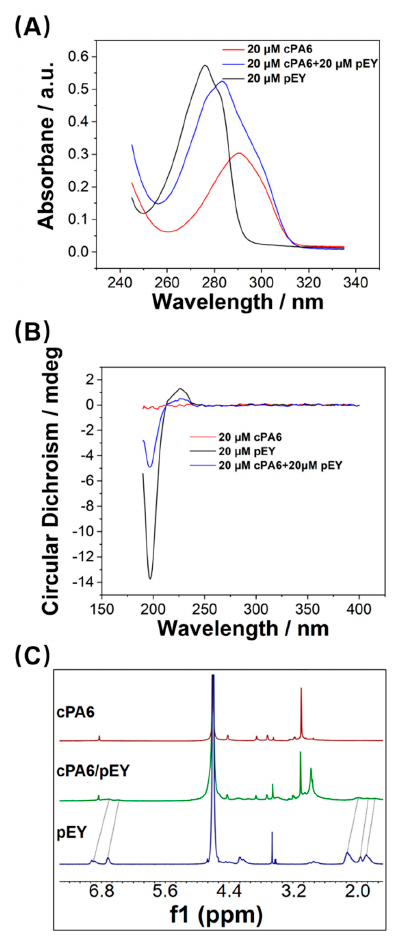
Figure 3. ( A ) Ultraviolet (UV) spectrum of pEY (black), cPA6 (red) and equivalent mixture of pEY with cPA6 (blue) in PBS (pH 7.2). ( B ) Circular dichroism spectra of pEY (20 μ M), cPA6 (20 μ M), and equivalent mixture of pEY with cPA6 (20 μ M, black) in PBS (pH 7.2). ( C ) 1 H nuclear magnetic resonance (NMR) spectra (500 MHz) of cPA6, pEY, and cPA6/pEY complex in 50 mM Tris-DCl buffer at pD 7.2.